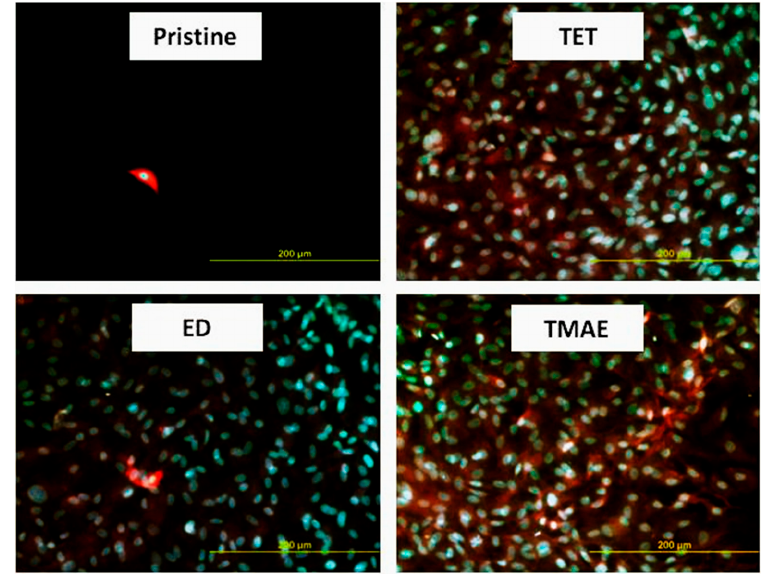
Figure 6. Photographs of VSMCs proliferated (6th day) on pristine HDPE and CNPs (ED, TET, TMAE) grafted HDPE. Chemicals used are ethylenediamine (ED), diethylenediamine (DET), tris[2-(methylamino)ethyl]amine